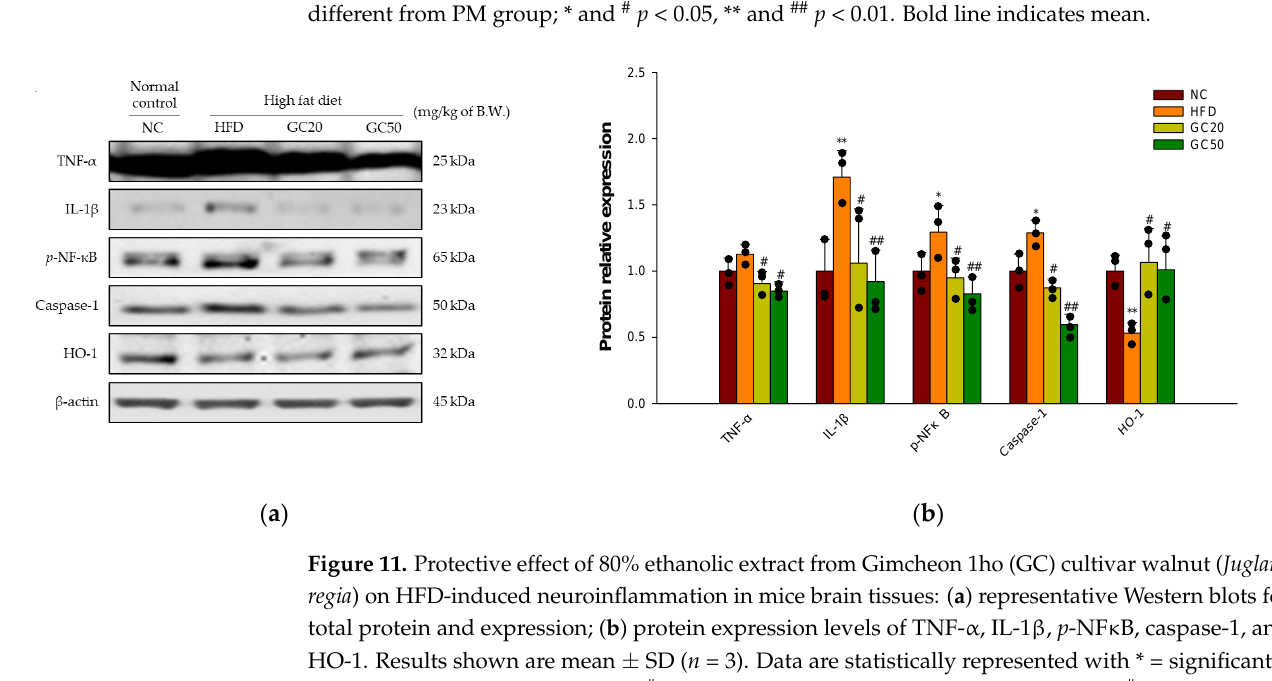
Figure 10. Protective effect of 80% ethanolic extract from Gimcheon 1ho (GC) cultivar walnut ( Juglans regia ) on HFD-induced synaptic disorders and neuronal apoptosis in mice brain tissues: ( a ) representative Western blots for total protein and expression; ( b ) protein expression levels of p -JNK, p -Akt, p -tau, IDE, A β , BAX, caspase-3. Results shown are mean ± SD ( n = 3). Data are statistically represented with * = significantly different from the NC group, and # = significantly different from PM group; * and # p < 0.05, ** and ## p < 0.01. Bold line indicates mean.